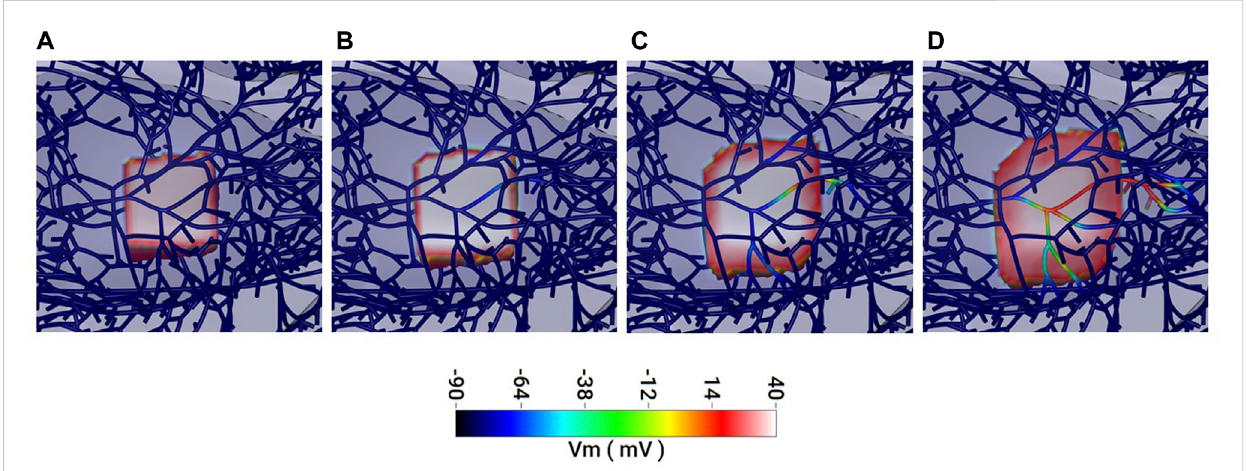
FIGURE 7 In silico simulation of the spread of activation in the myocardium and Purkinje fi bre network. (A – D) 1 ms sequential frames representing an area of myocardium and associated Purkinje network (dark blue strands in A). (A) Myocardium, only, within a 2 mm cubic region is activated (pink/red) and the depolarisation spreads outwards through (B) to (D) . (B, C) Some Purkinje fi bres within the depolarised region become activated retrogradely and conduction through these fi bres propagates. (D) Faster conduction in the Purkinje fi bres results in Purkinje-mediated propagation outpacing that from the myocardium. See Supplementary Figure S3 for a video of this effect in the full